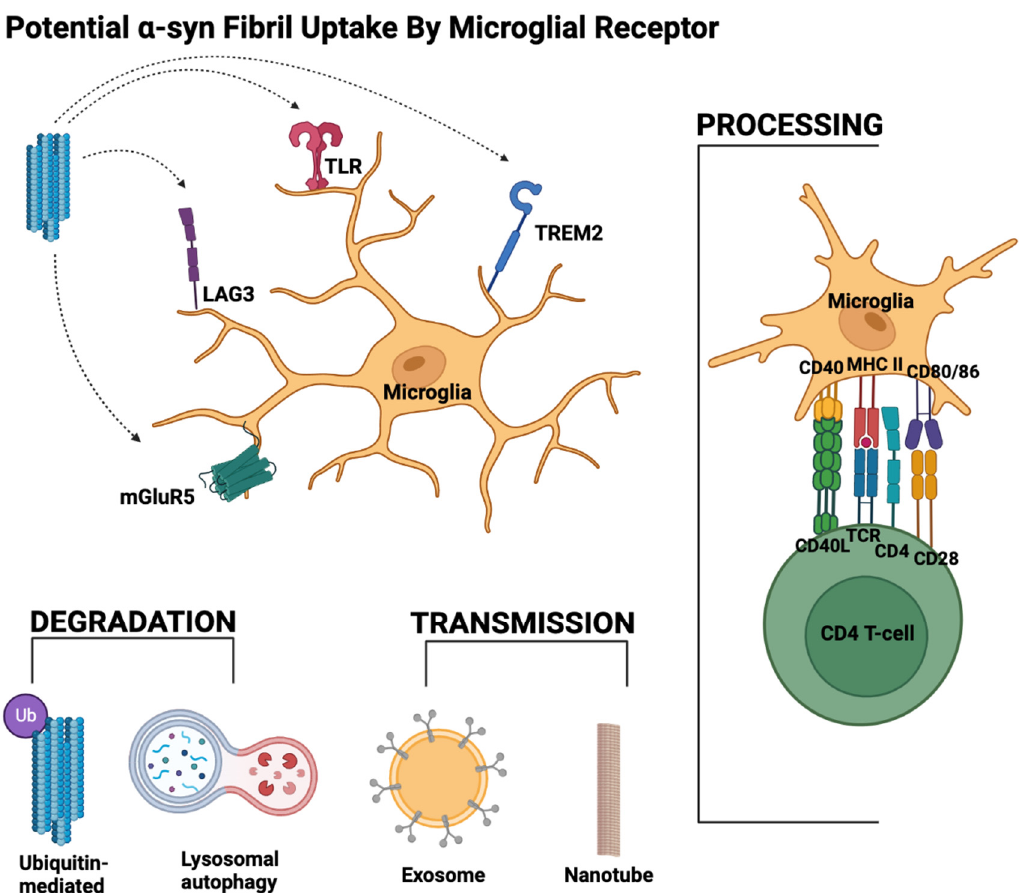
Figure 2. Microglial interaction with α -syn and downstream effects. Summary of the pathologic aggregation of α -syn in the CNS, the potential receptor interactions on the microglial surface, and the downstream effects after uptake of α -syn, including degradation, transmission, or processing. α -syn uptake potentially occurs via interacting with TLRs, LAG3, TREM2, and/or mGluR5 although repeated evidence of such interactions is pending. After uptake, α -syn can be degraded by the microglial cell through ubiquitin-mediated proteasome activation or lysosomal-mediated autophagy. Instead of uptake, α -syn can also be transmitted to other microglia, particularly if the existing microglia have a high α -syn burden. Transmission of α -syn occurs through exosomes or via nanotubes connecting microglia. Lastly, a microglial cell can process and present α -syn on its MHCII receptor to activate downstream immune cascades [147].